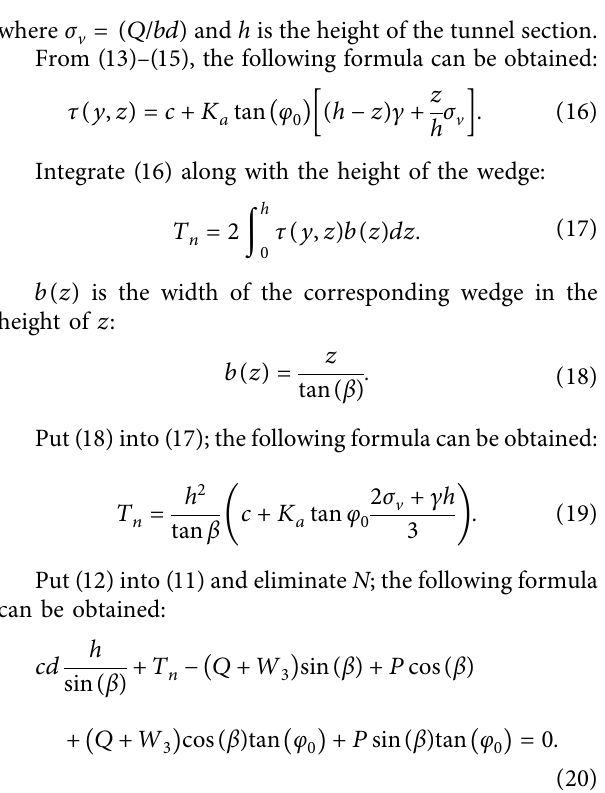
Figure 3: A calculation model of the unsupported span. (a) Three-dimensional model. (b) Failure mode of the arch crown. (c) Failure mode of the tunnel